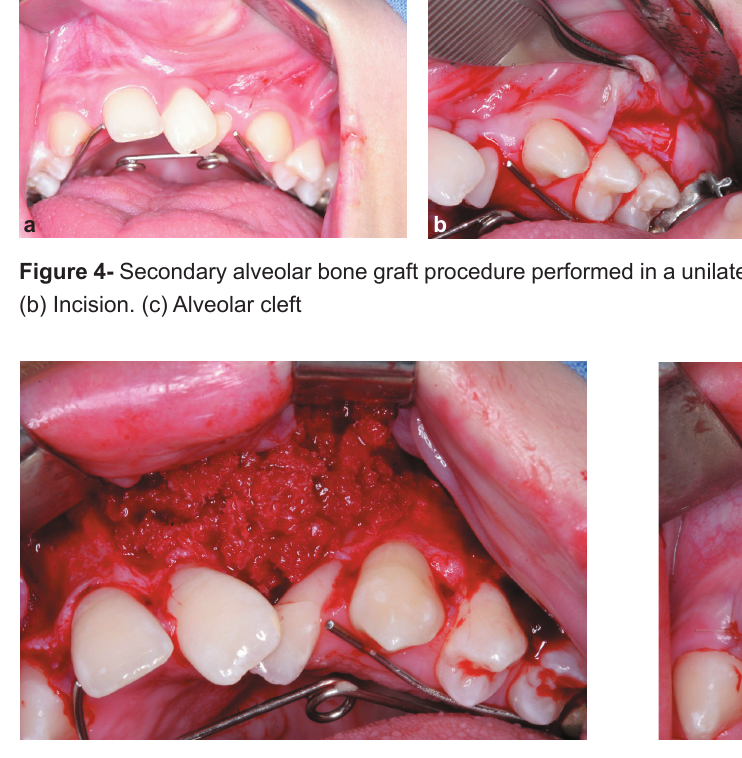
Figure 5- Placement of cancellous bone from the iliac